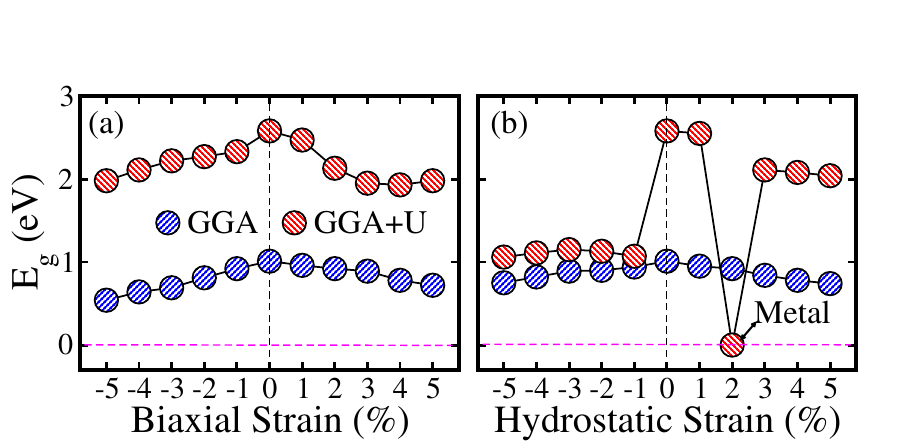
Figure 5. Calculated GGA and GGA+ U energy band gap ( E g ) in the spin-majority/minority channel of